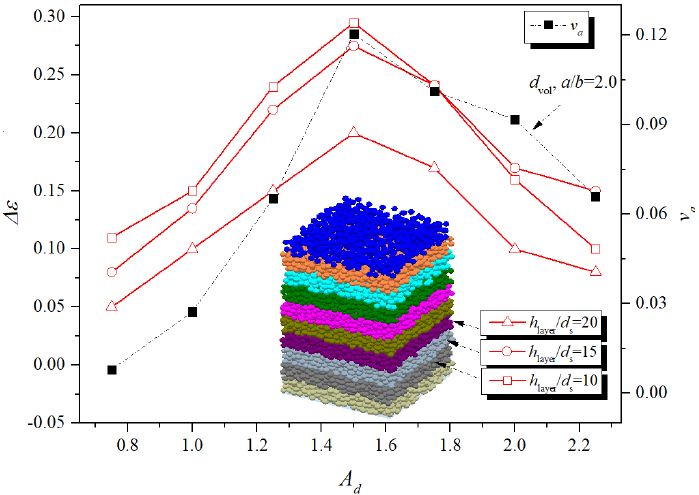
Figure 5. Influence of A on ∆ ε for different bed layers ( ○ , □ , and △ ) and v a ( ■ ), f = 20 Hz.